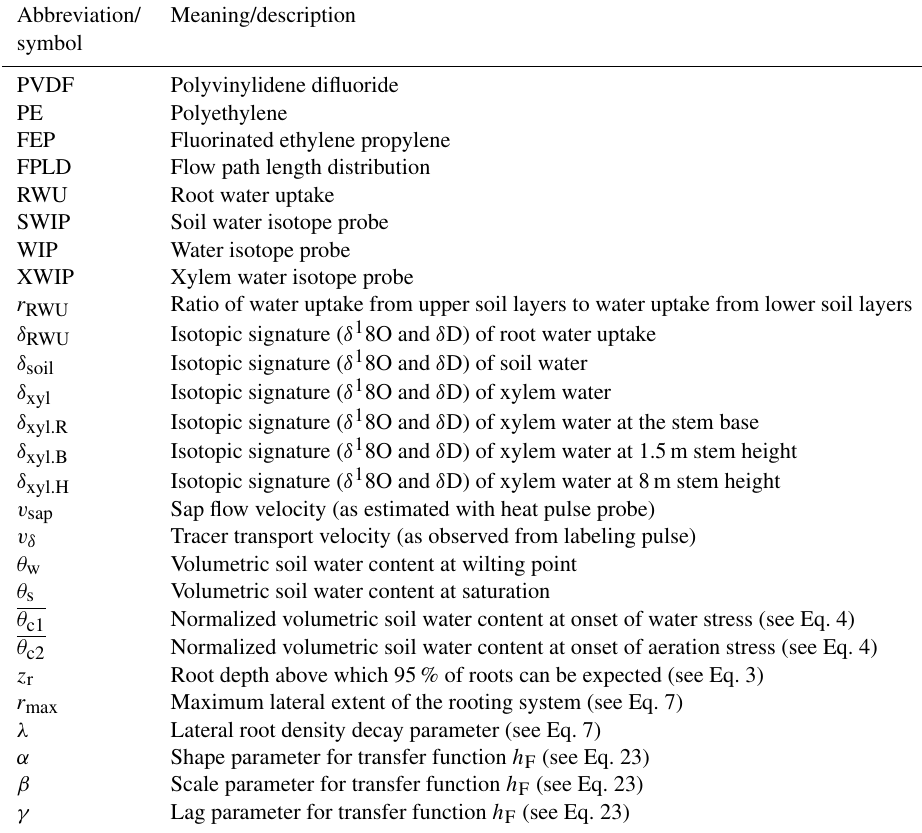
Table A1. Abbreviations and parameter symbols used within this article and their